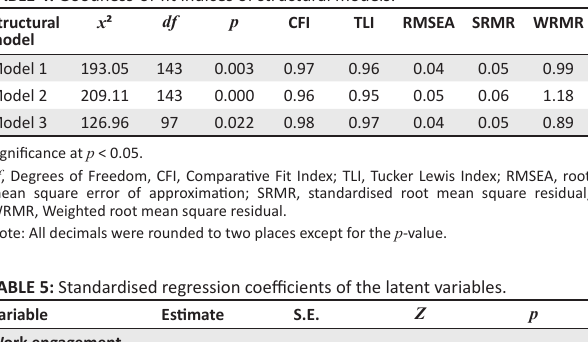
TABLE 2: Correlation matrix of latent variables. Variable